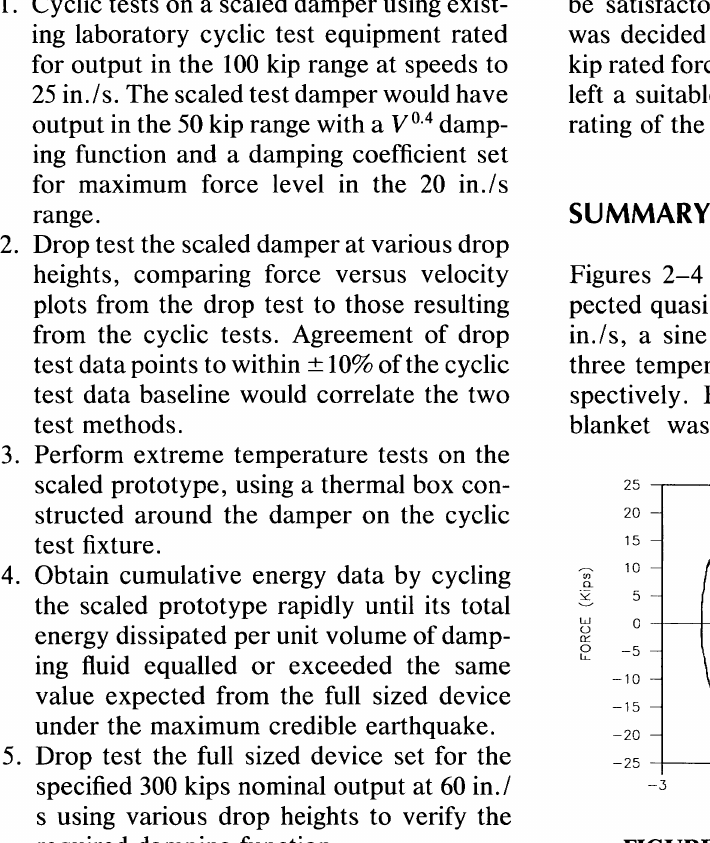
FIGURE 2 Cyclic test data, 1 in./s,